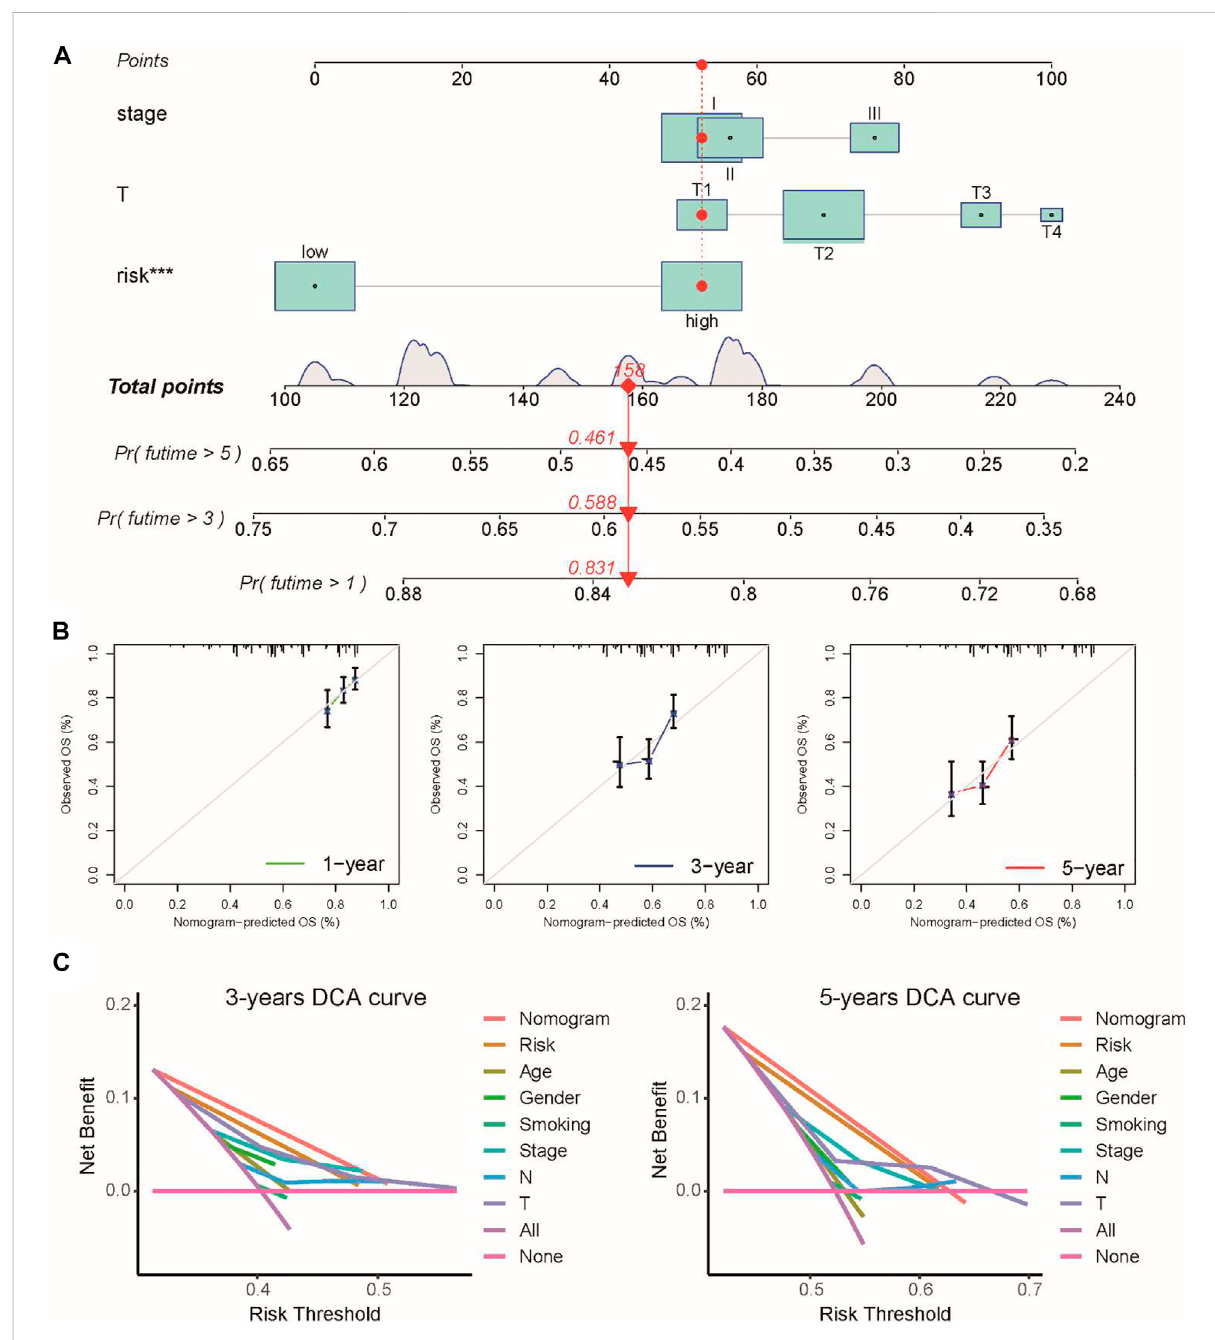
FIGURE 3 Prognostic nomogram was constructed by combining clinical stage, T stage, and risk score in the TCGA cohort. (A) Prognostic nomogram for predicting the 1-, 3-, and 5-year survival rates of LUSC patients. (B) Corresponding calibration curve for 1-, 3-, and 5-year OS prediction. (C) DCA curve for the prediction of 3-year and 5-year overall